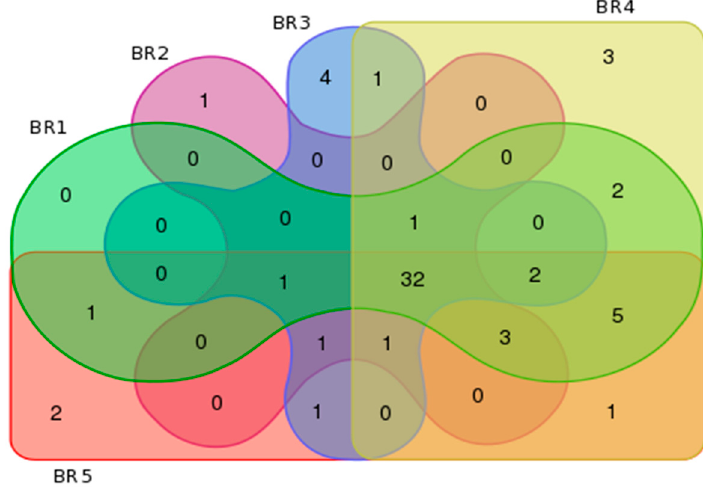
Figure 5. Metabolite similarity and uniqueness characterization.